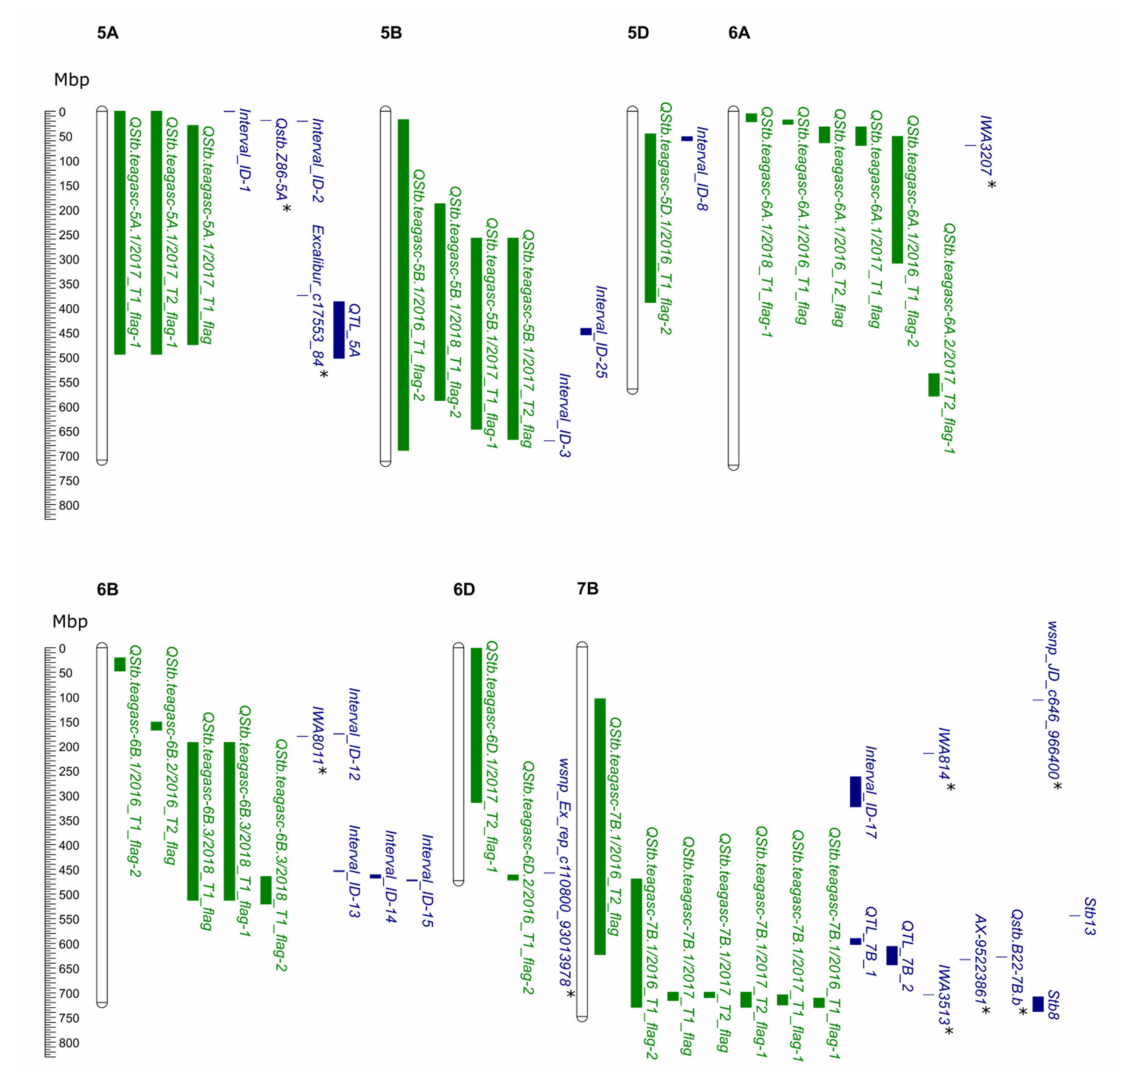
Figure 3. Physical map locations (megabase pair—Mbp) of septoria tritici blotch (STB) QTL detected in the current study compared to previously reported QTL. QTL locations and interval sizes are indicated by bars on the right-hand side of each chromosome and are based on the physical map information in Table 5 and Table S5. The physical map location was based on the wheat cv. Chinese Spring IWGSC RefSeq v1.0 genome assembly (IWGSC, 2018). The QTL name assigned in this study (presented in Table 5; green colour) is followed by the environment in which the QTL was detected. Previously reported QTL are indicated in blue, where the displayed QTL are only defined on the physical map by anchoring one of the two flanking makers indicated by a